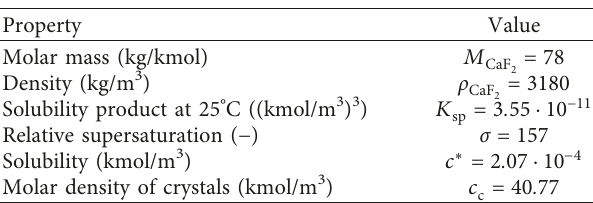
Figure 5: Ranges of homogeneous and heterogeneous nucleation [2] with the marked working point from CaF Table 4: Calculation data.